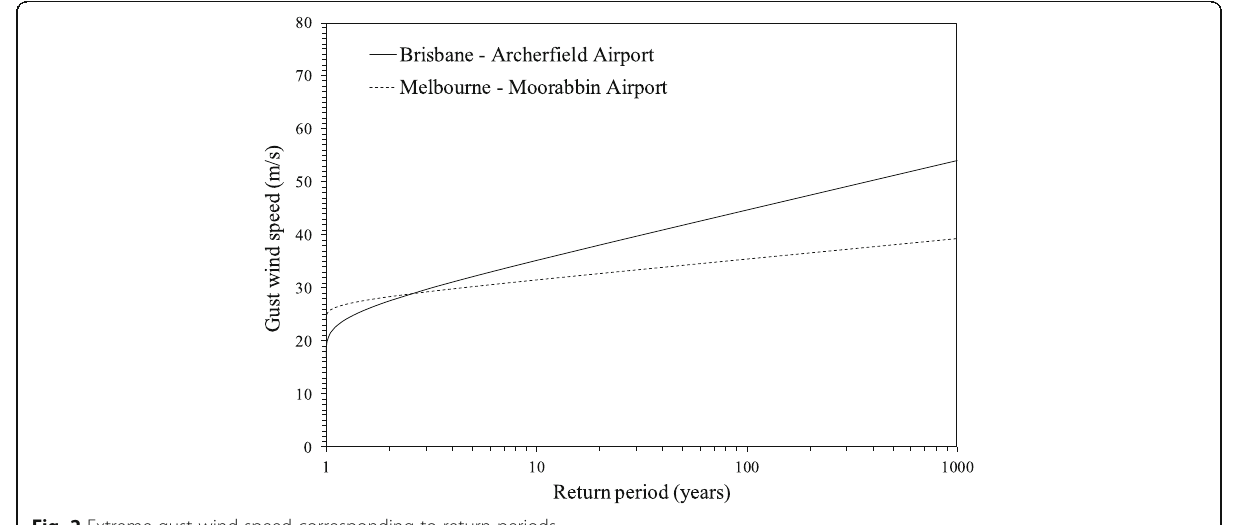
Fig. 2 Extreme gust wind speed corresponding to return